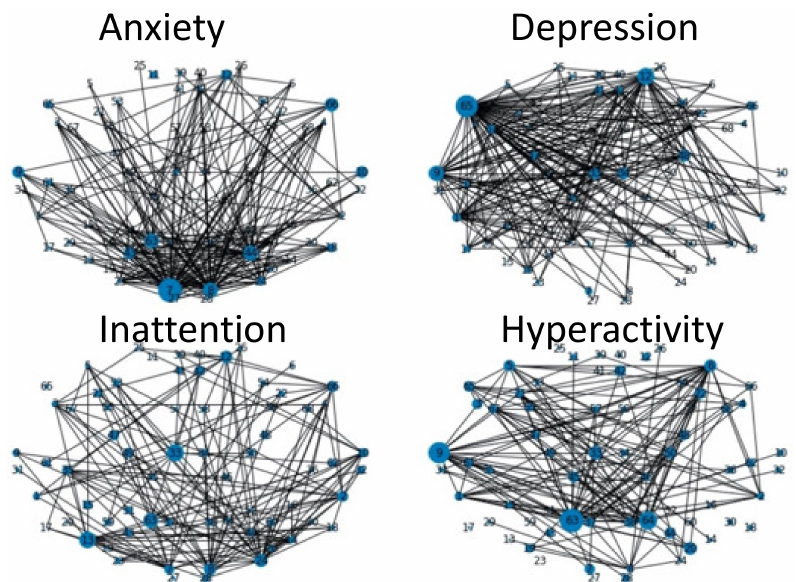
Figure 5. Topographical plot showing “strength” of ROI connections of relevance to mental health disorders, anxiety ( upper left ), depression ( upper right ), inattention ( bottom left ), and hyperactivity ( bottom right ). Size of each vertex corresponds to sum of chi-square statistic of the vertex. An edge is created when the sum of chi-square statistic of the two vertices that share the edge exceeds threshold: 100. The thickness of all edges is the same.